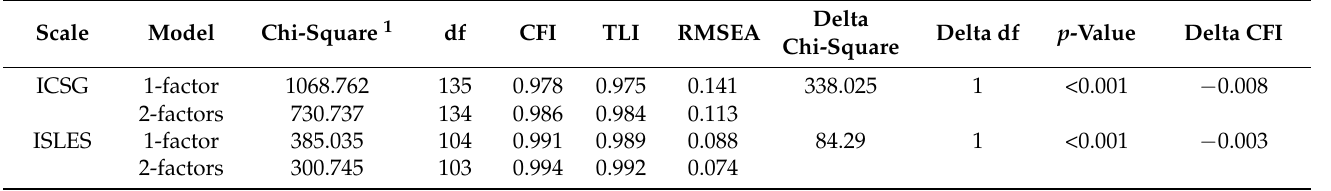
Table 1. Results of Confirmatory Factor Analysis ( n =